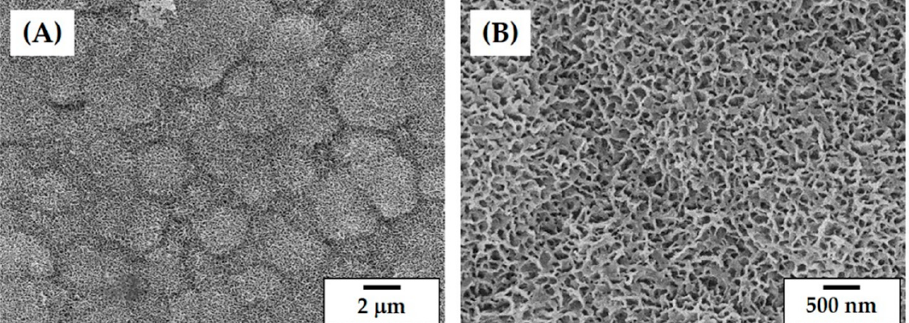
Figure 14. Representative FE-SEM images of the surface morphologies of the CaP frameworks showing the deposition of apatite crystals after immersion in an SBF solution for 1 day ( A ) at low and ( B ) at high magnifications.